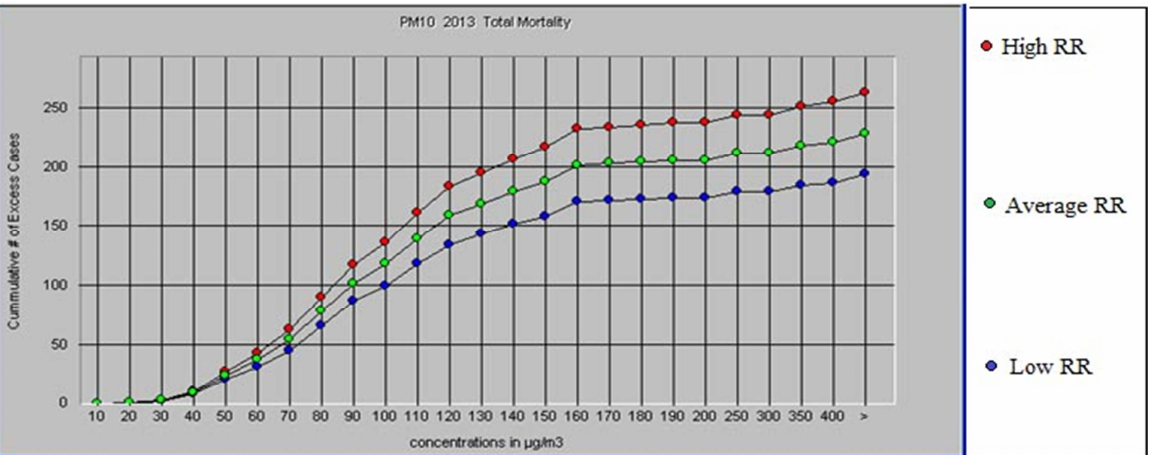
Figure 4. Percentage of a number of cases that are exposed to different concentrations of particulate matter with aerodynamic diameters <10 µm